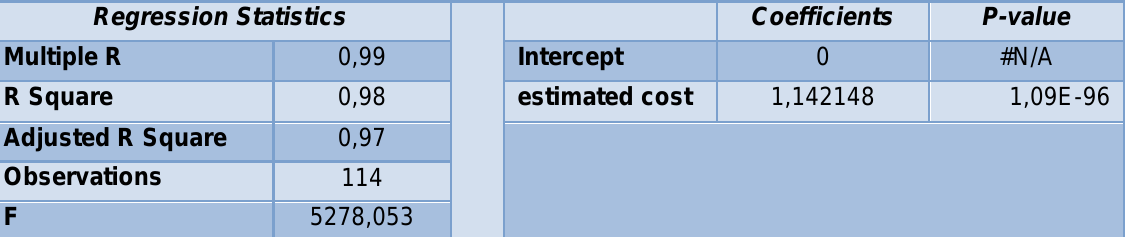
The coefficient of determination R2 is 0.98 for both models as shown in Table 6 and 7. Both models give better R2 when the intercept is set to zero. The coefficient of estimated cost in the first model is greater than it in the second one which means that the relative cost deviation tends to be larger in small projects.